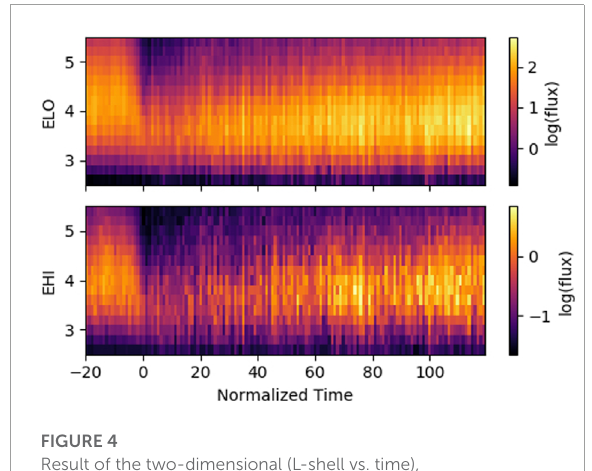
FIGURE 4 Result of the two-dimensional (L-shell vs. time), time-normalised superposed epoch analysis for SAMPEX PET fluxes between 1992 and 2004, for 168 geomagnetic storms. The colors are on a logarithmic scale, and show flux from the low energy (ELO, 1.5–6.0 MeV) electron channel on the top panel and from the high energy (EHI, 2.5–14.0 MeV) electron channel on the bottom